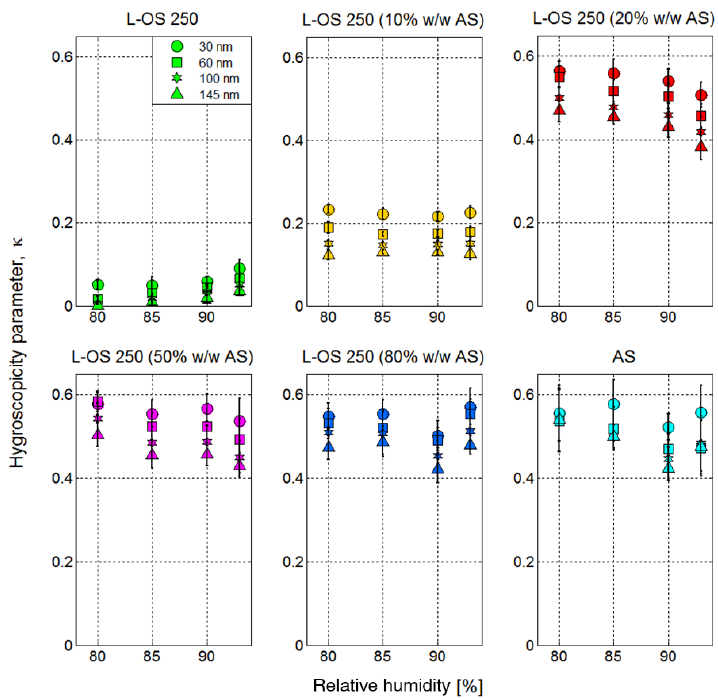
Figure 6. Hygroscopicity parameter, κ , obtained from the H-TDMA measurements, as a function of RH for the six mixtures of L-OS 250 and AS. Error bars represent ± 2 standard deviations on κ as described in Sect.